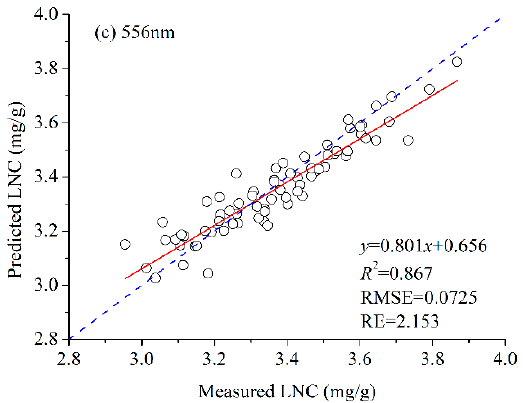
Figure 9. Relationship between the predicted LNC by using PCA combined with BPNN and the measured LNC for different excitation light wavelengths. ( a ) 355 nm, ( b ) 460 nm, ( c ) 556 nm. The blue dotted line is the 1:1 line. The red solid line is the linear regression.